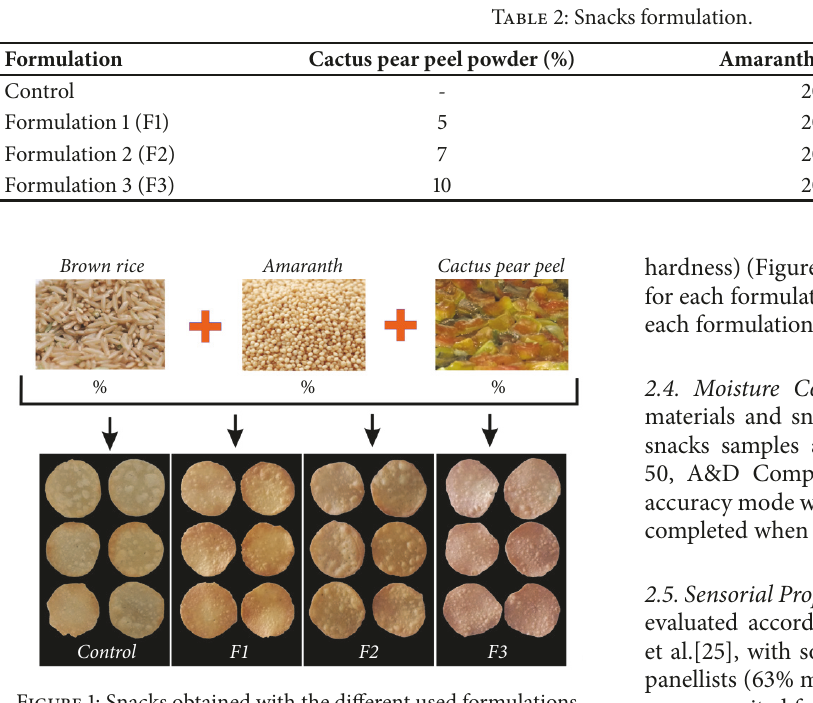
Figure 1: Snacks obtained with the different used formulations.